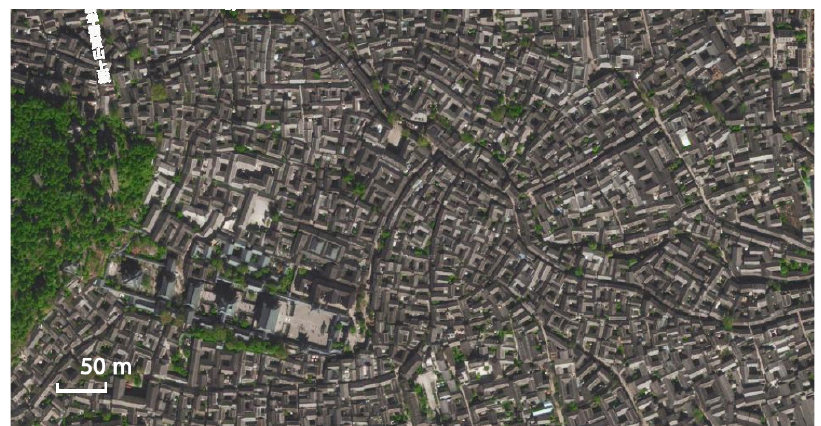
Figure 9. The urban fabric of Dayan town (Satellite map from Baidu